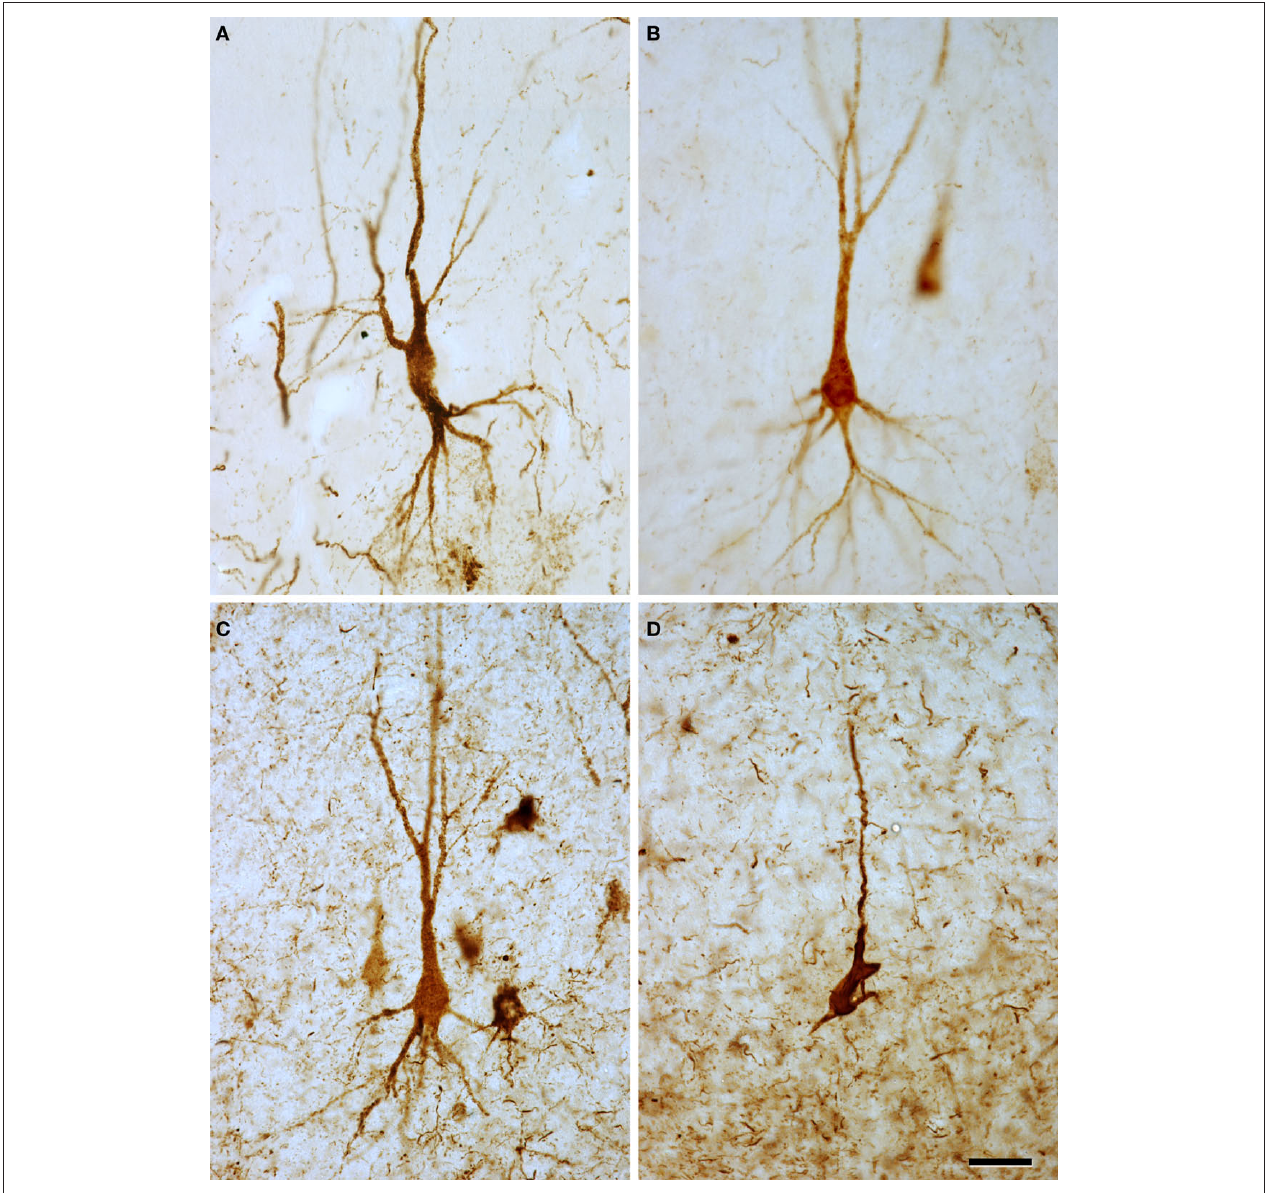
staining, which is characterized by a diffuse cytoplasmic staining and the neurons display a normal morphology. (D) Correspond to pattern II of PHF-tau staining, which is characterized by the presence of NFT. These neurons appear to have fewer processes probably due to neuronal atrophy. Scale bar: 37.5